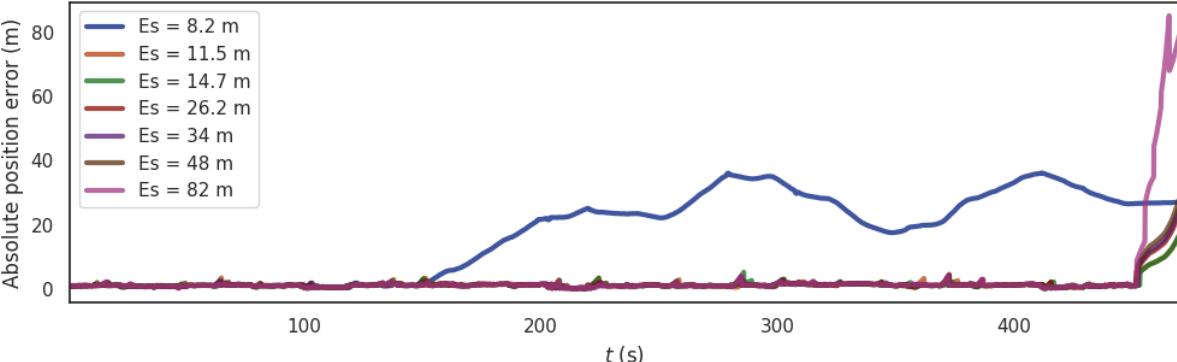
Figure 9. The trend of APE under different localization verification thresholds of inducing spoofing.